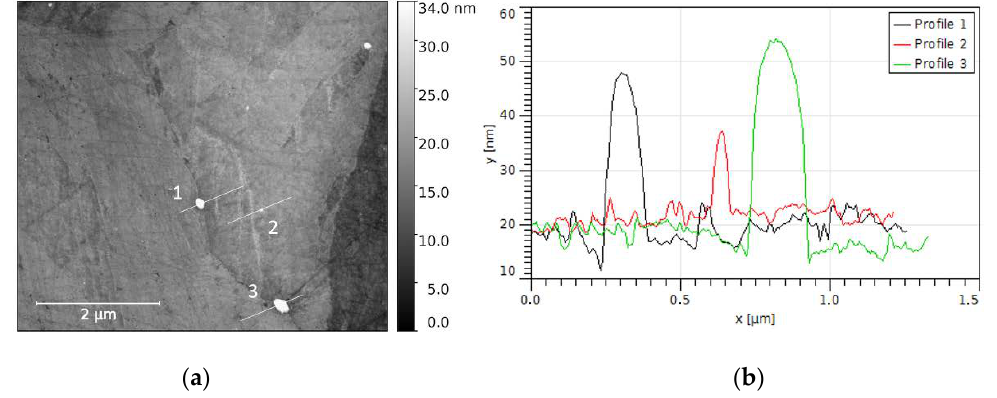
Figure 3. AFM (atomic force microscopy) measurement of particles in a martensitic microstructure with particles on grain boundaries and within the grains ( a ) and the corresponding line profiles of three selected particles of different sizes ( b ).